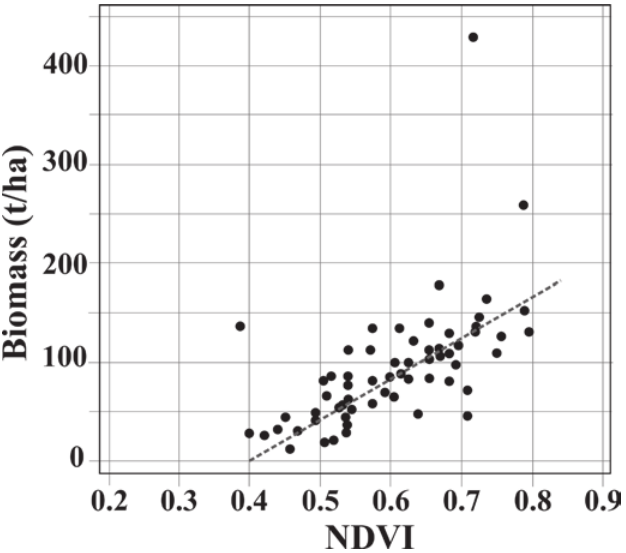
Figure 2 - Correlation of Total Living Biomass (TLB, in tons per hectare) and NDVI values showing a near linear model for wooded areas with none saturation (Gizachew et al. 2016).